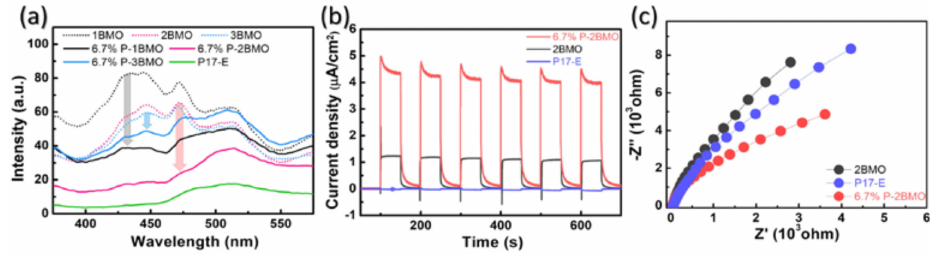
Figure 5. ( a ) Photoluminescence (PL) spectra of all of the samples; ( b ) photocurrent response spectra; and ( c ) electrochemical impedance spectra of 2BMO, P17-E, and 6.7%